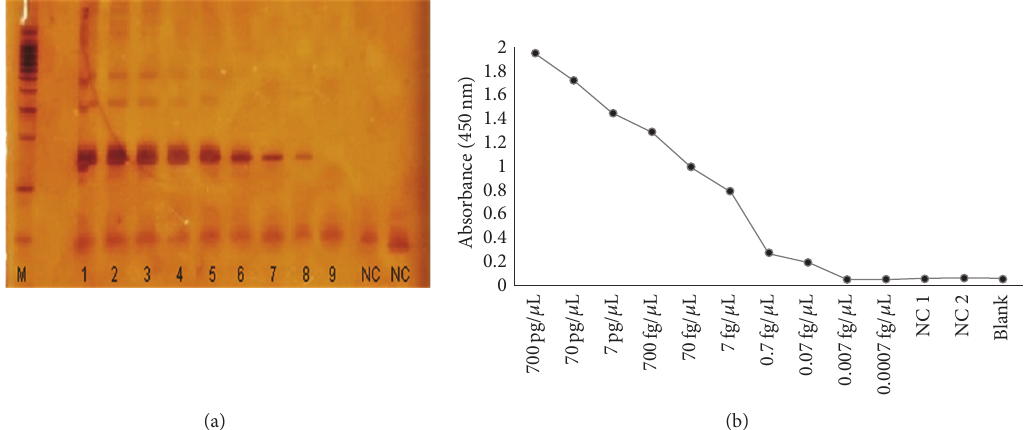
Figure 1: Analytical sensitivity of the conventional PCR and kDNA PCR-ELISA in L. infantum gDNA. (a) Analytical sensitivity of 6% polyacrylamide gel and (b) kDNA PCR-ELISA for the detection of PCR products from DNA extracted of L . infantum at concentrations of 1: 700 pg, 2: 70 pg, 3: 7pg, 4: 700 fg, 5: 70 fg, 6: 7fg, 7: 0.7 fg, 8: 0.07 fg, and 9: 0.007 fg/ 𝜇 L; NC: negative controls and M: 100 pb DNA Ladder (Promega).